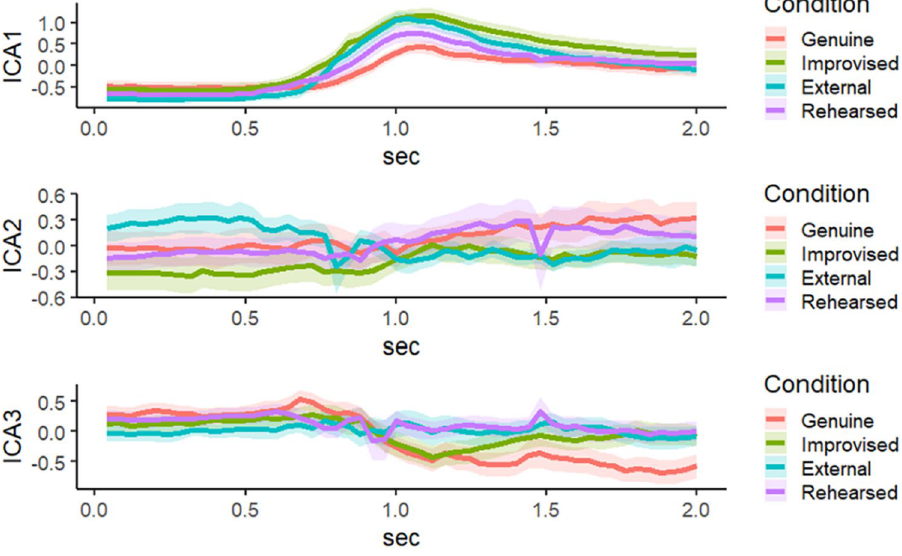
Figure 2. Independent Component among the four expression conditions. The ribbons represent ± 1 standard